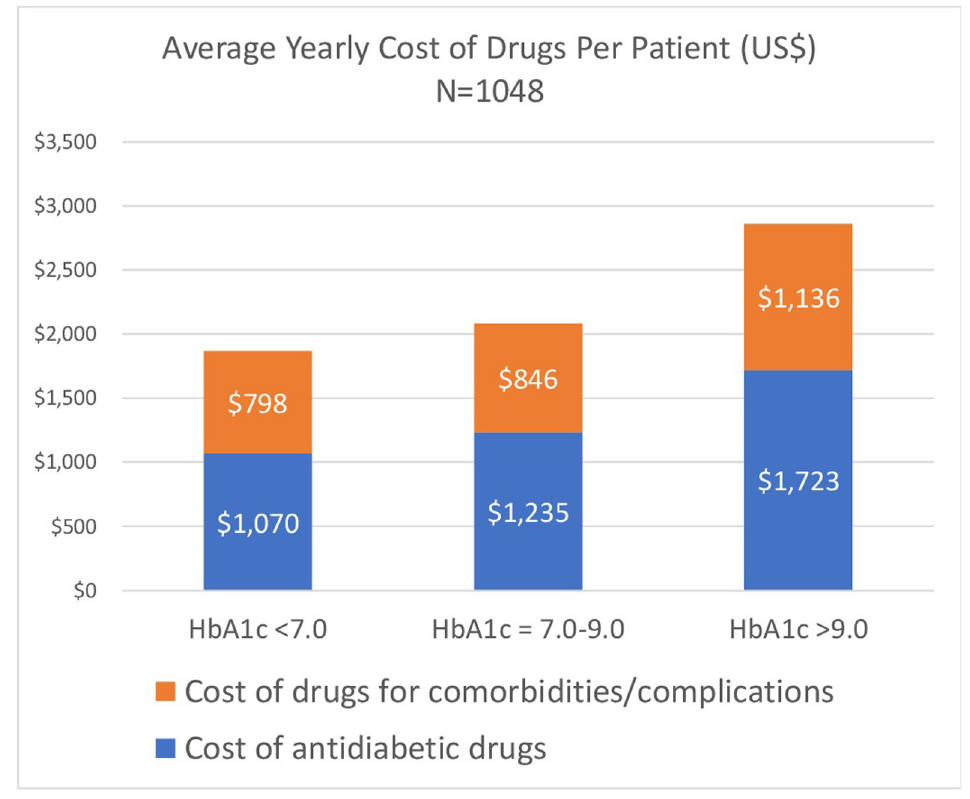
Fig 4. Average price for drugs per year, by patient groups based on HbA1c level (N = 1048).